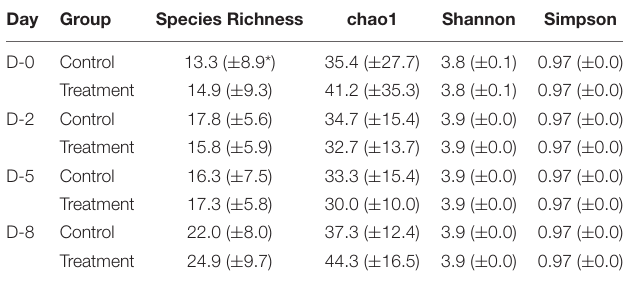
TABLE 2 | Comparison of α diversity between treatment and control groups at different time